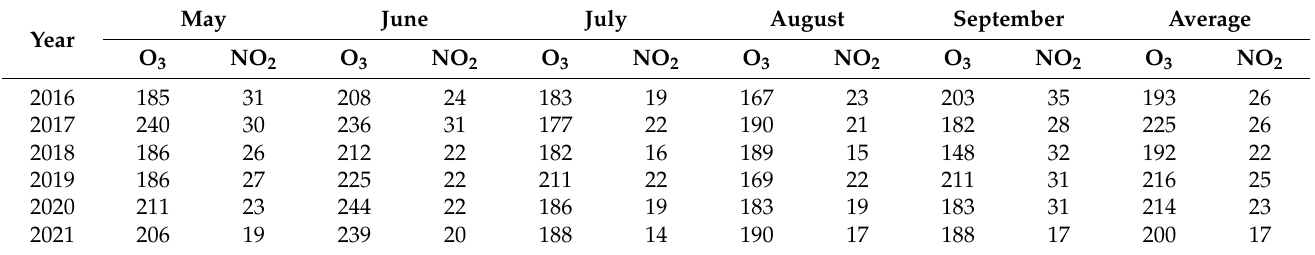
Table 2. Monthly mean concentrations of maximum 8 h O 3 and NO 2 ( µ g/m 3 ) in Tai’an